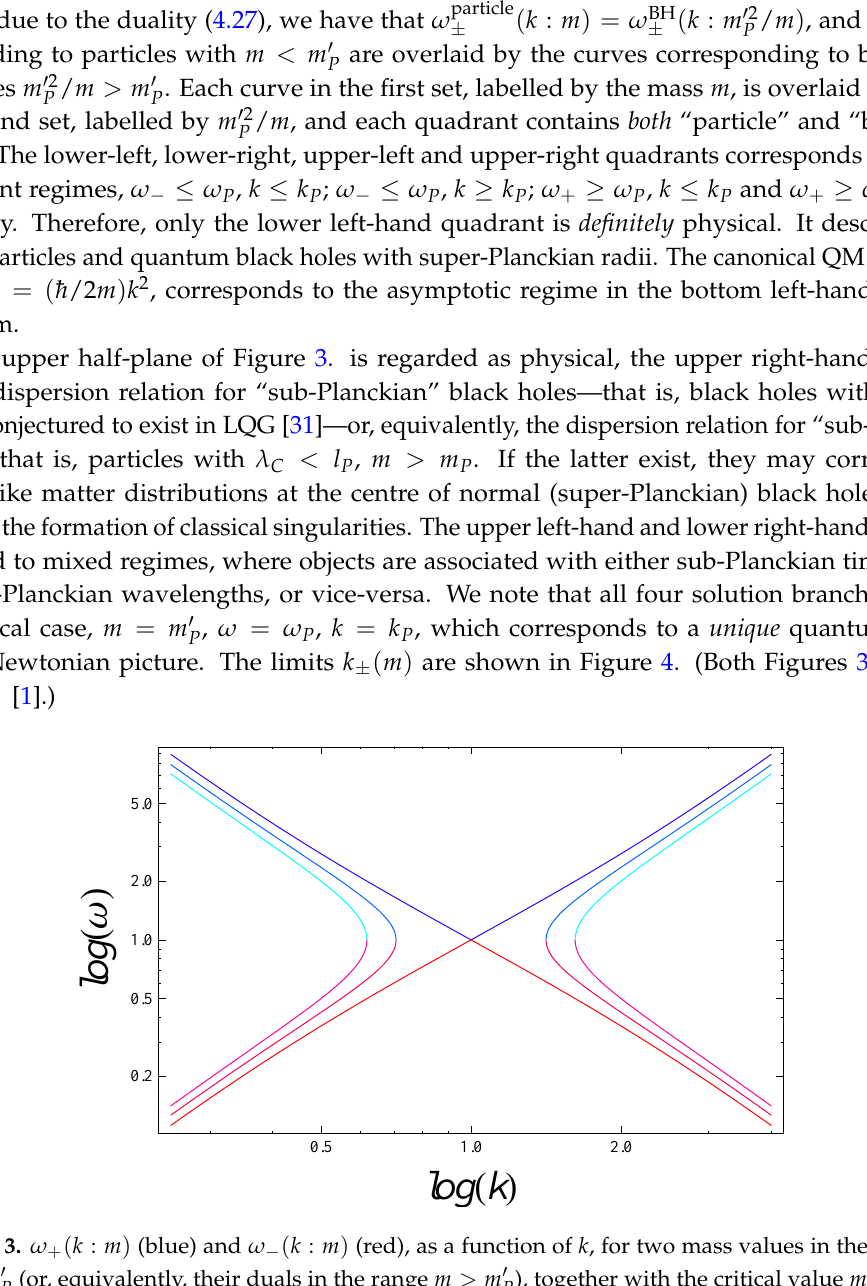
), together with the critical value m = m (cid:48) P